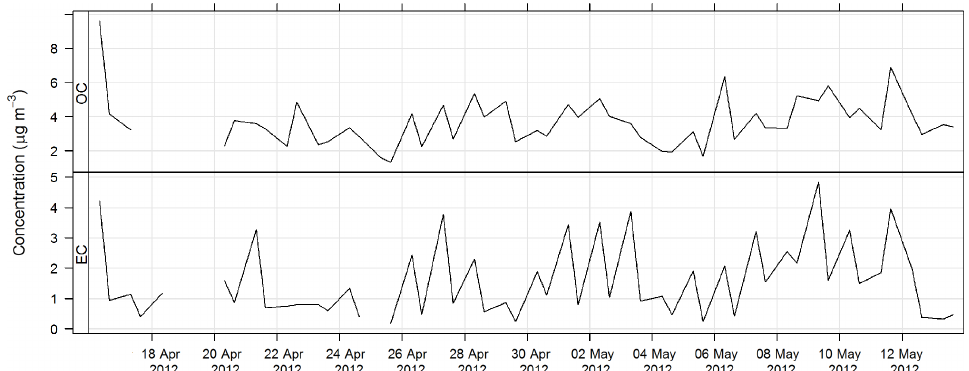
Figure 18. Time series of OC and EC during SPS-II in 2012.